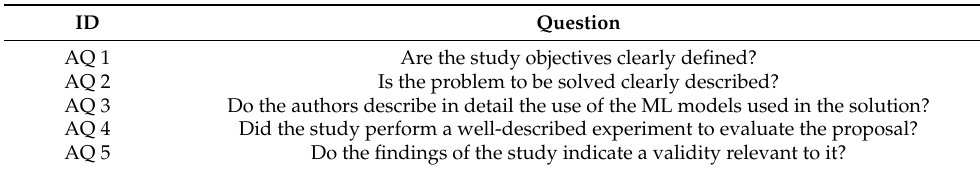
Table 6. Questionnaire for quality evaluation.